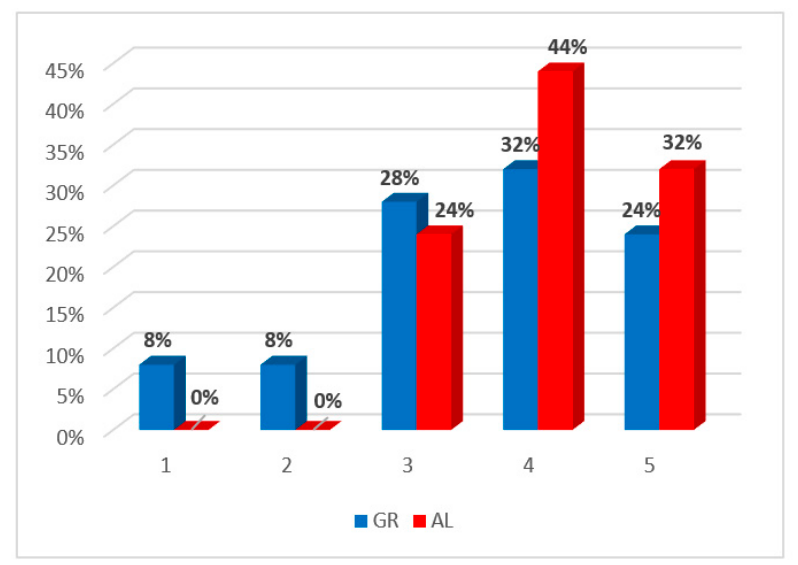
Figure 1. Contribution of the experience gained in the business acceleration program to the develop- ment of the participant’s business idea.